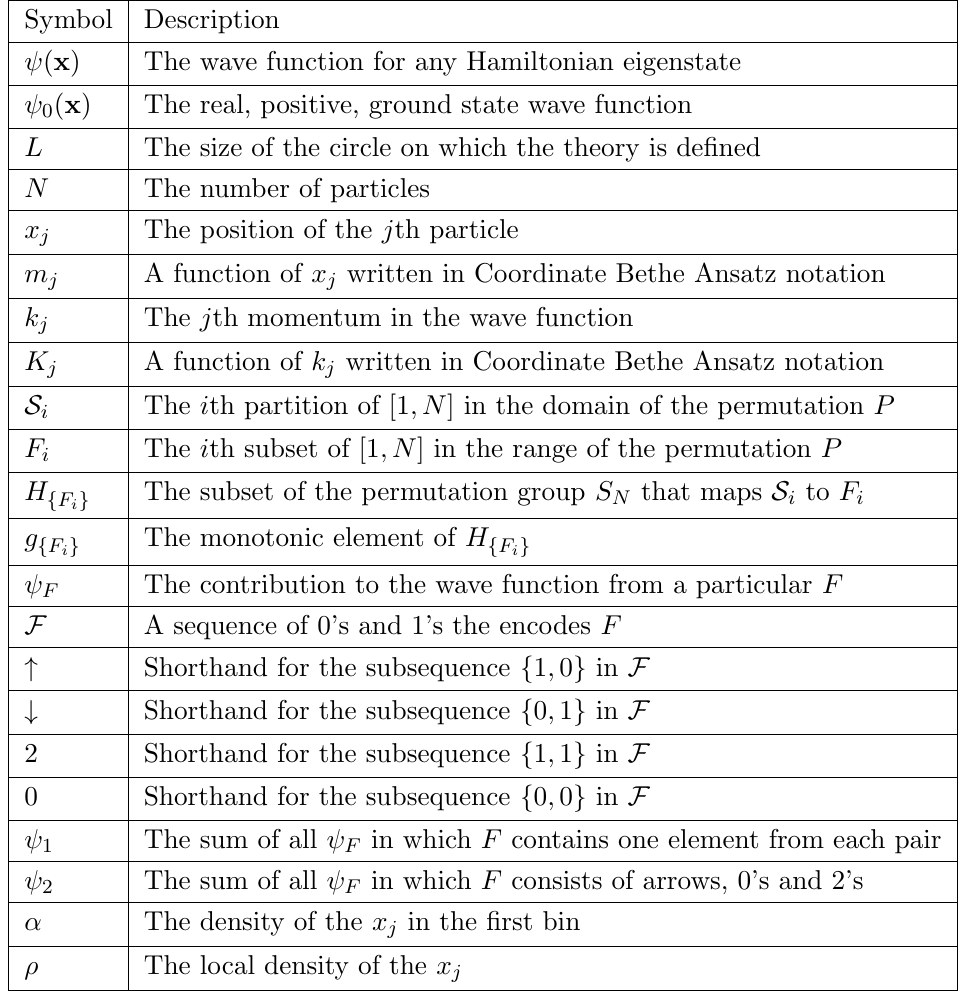
Table 1 . List of